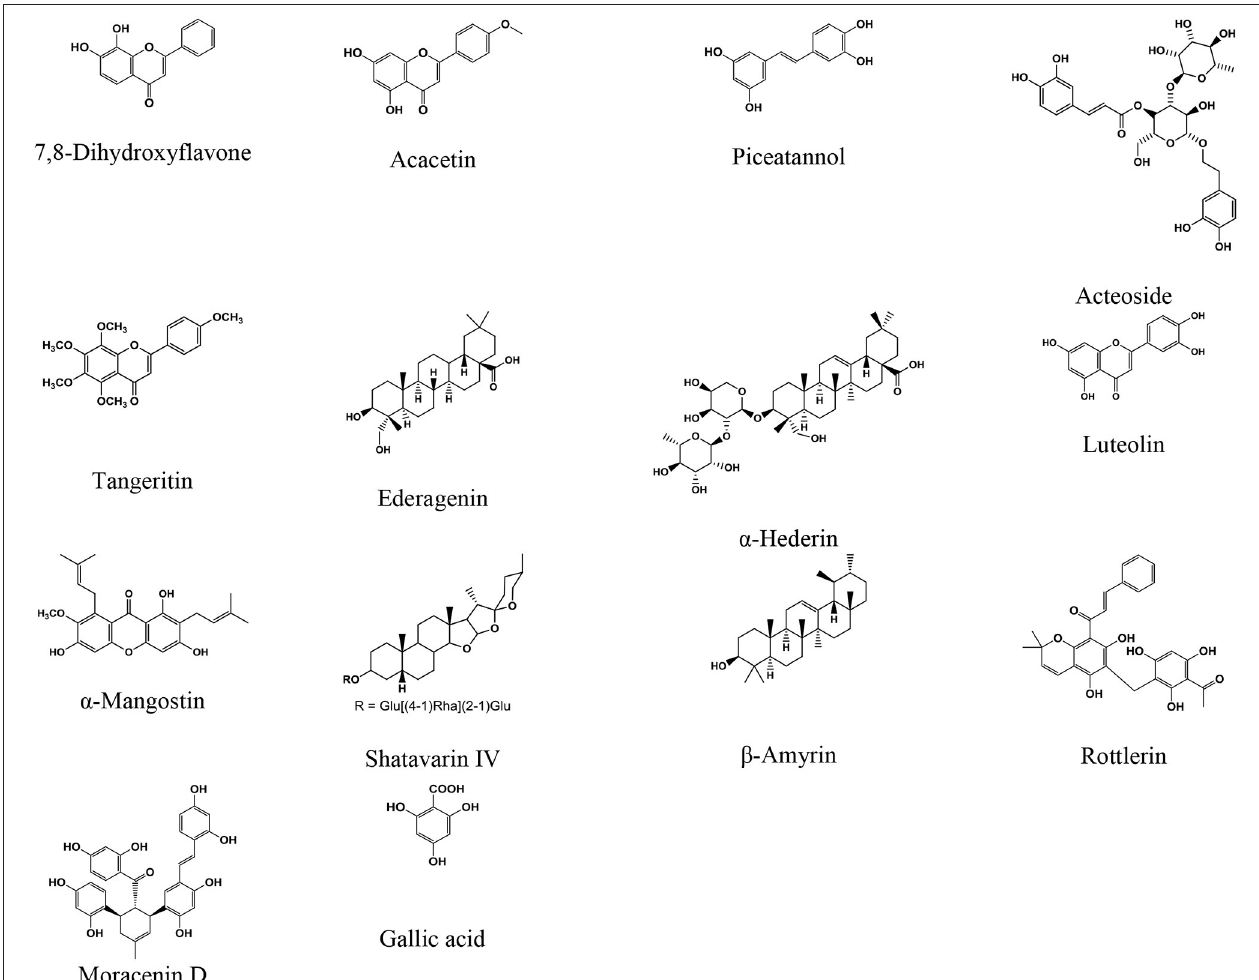
FIGURE 1 | Chemical structure of the phytochemicals attenuating α -synuclein activity in animal models of Parkinson’s